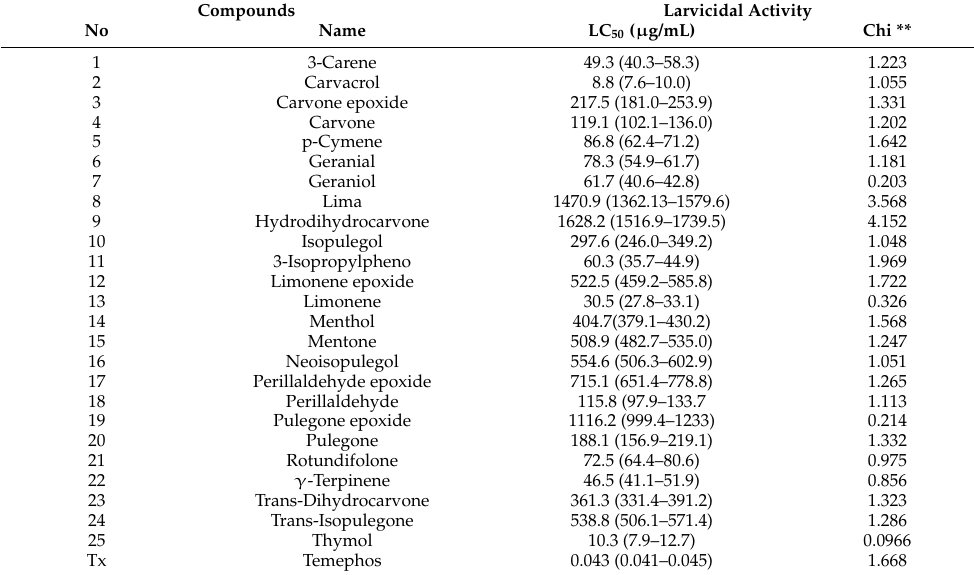
Table 1. LC 50 of terpenes and derivates on Aedes aegypti at III instar.